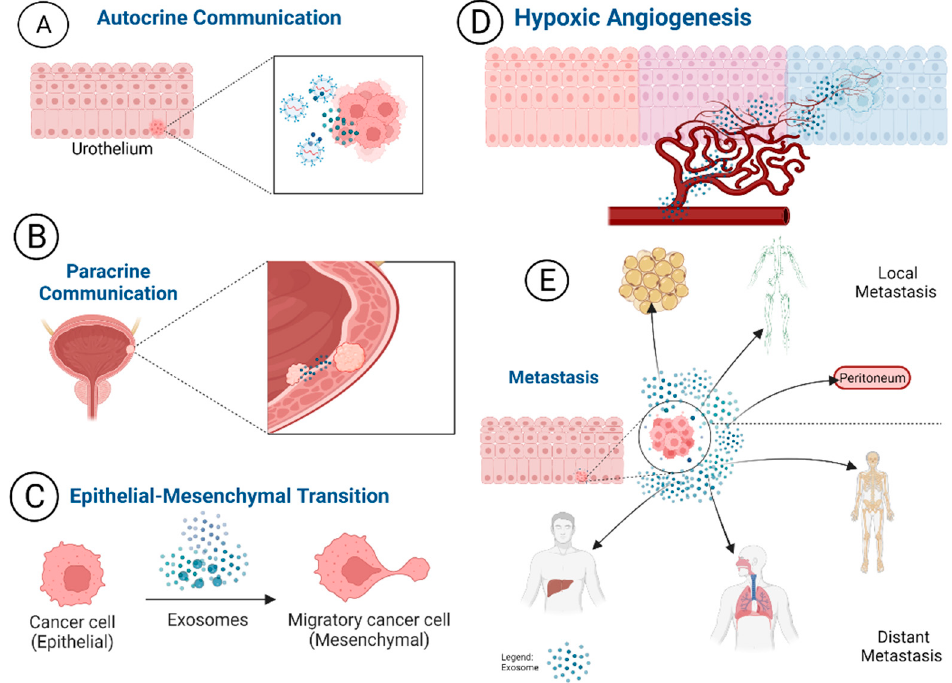
Figure 2. Exosomes are involved in cancer cell development, proliferation, and survival. ( A ) Through autocrine communication, exosomes communicate to the cells they are released from to promote a suitable microenvironment for tumors and contribute to the activation of pro-tumor mu- tations within their host cell. ( B ) Paracrine communication allows exosomes to communicate to